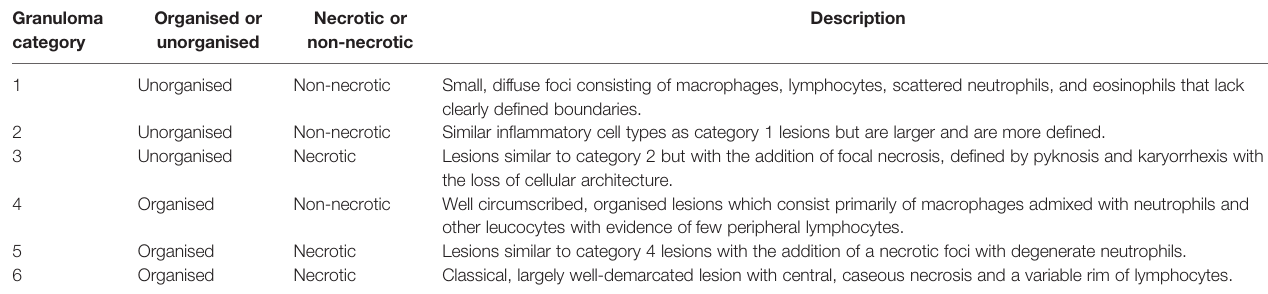
TABLE 2 | Granuloma category descriptions. Modi fi ed from Rayner et al.